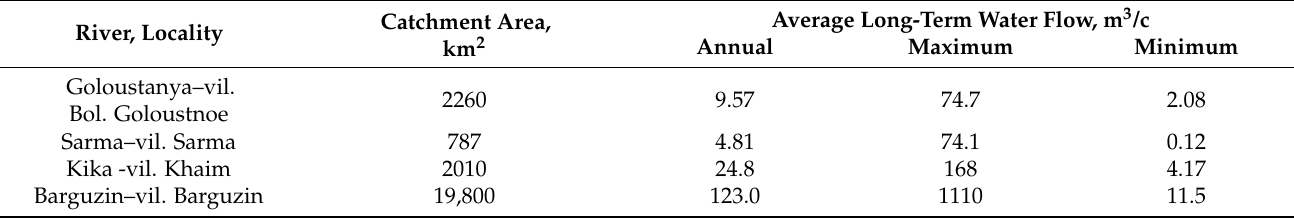
Table 1. Hydrological characteristics of the